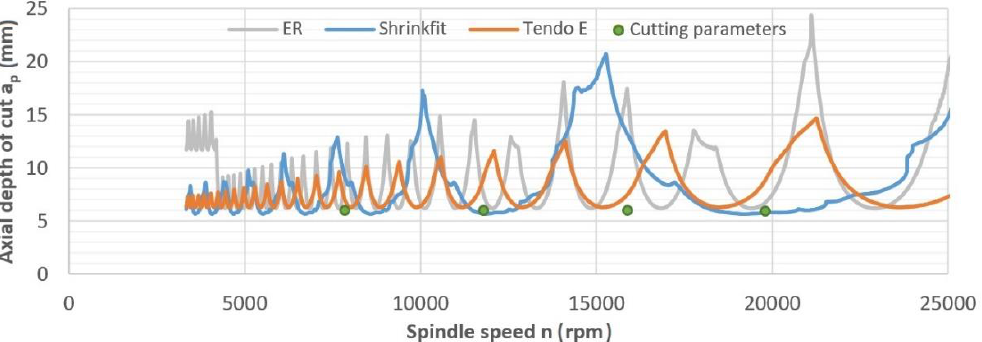
Figure 4. Stability curves for the tool mounted in ER collet chuck, heat shrink chuck, and Tendo E hydraulic chuck (f z = 0.15